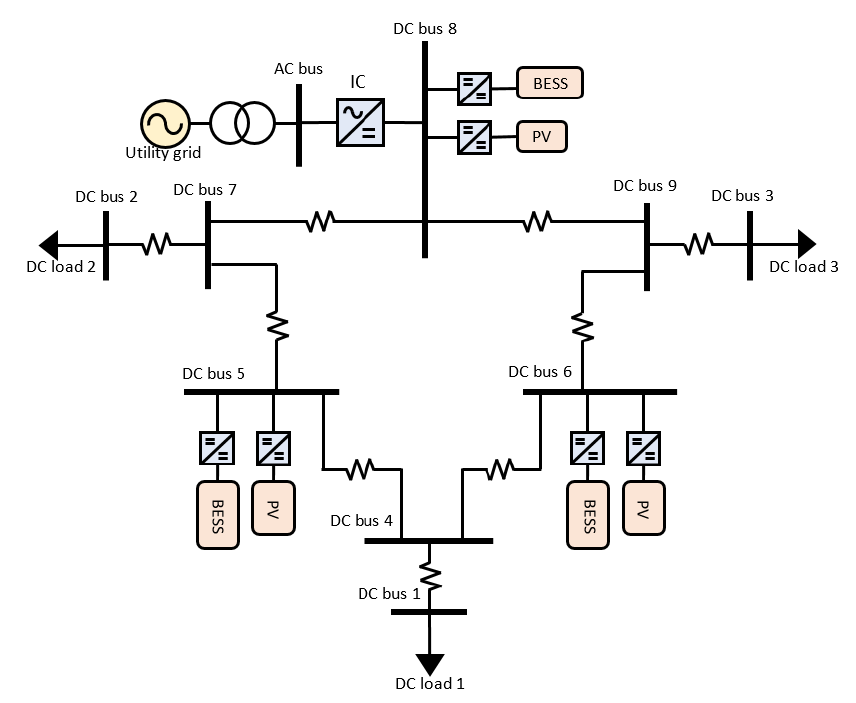
Figure 4. Configuration of a DC microgrid system.